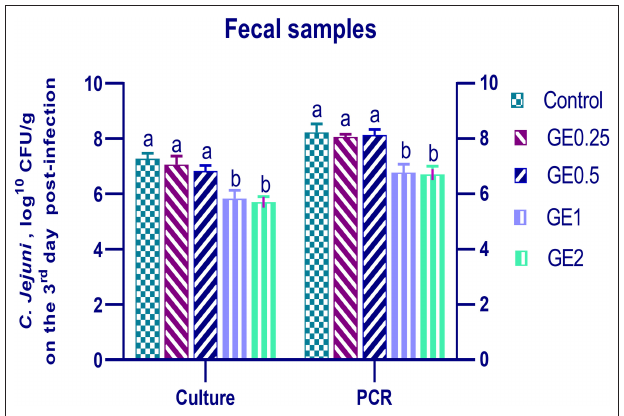
FIGURE 3 | Effects of dietary supplementation of Glycyrrhiza extract on C. jejuni population in fecal samples 3 days post-infection. Control referred to basal diet. GE0.25, GE0.5, GE1, and GE2 referred to basal diet supplemented with 0.25, 0.5, 1, and 2 g/kg Glycyrrhiza extract, respectively. Data represent mean values from 10 independent experiments, error bars indicate SE, n = 20 per group. C. jejuni count was significantly decreased in all groups supplemented with GE compared with the control group ( P < 0.05) except for GE0.25 and GE0.5 showing non-significant difference ( P > 0.05).